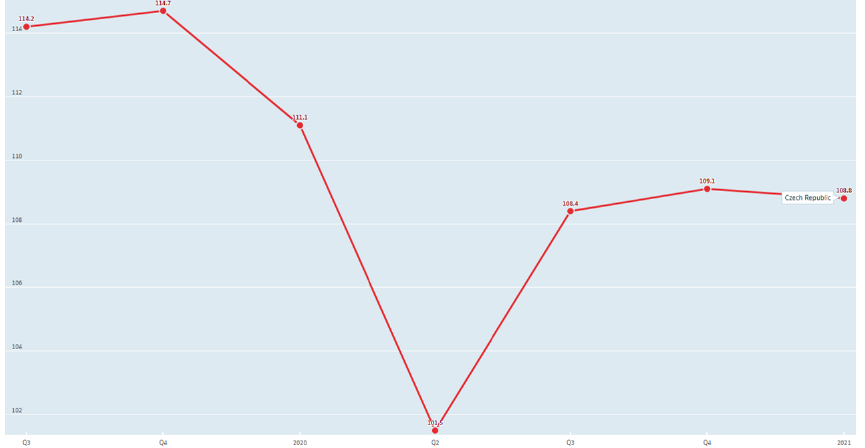
Figure 2. The percentage changes in quarterly GDP in the Czech